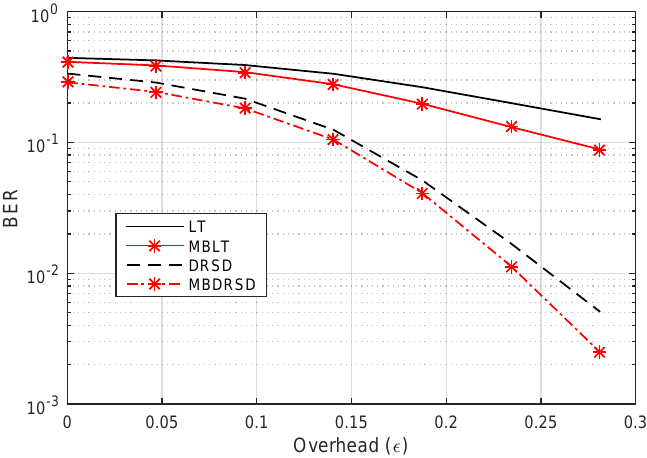
Figure 11. BER versus the overhead ( (cid:101) ) for different coding schemes at k = 256 and erasure probabilities of ε 1 = 0.01, ε 2 = 0.01, and ε 3 = 0.